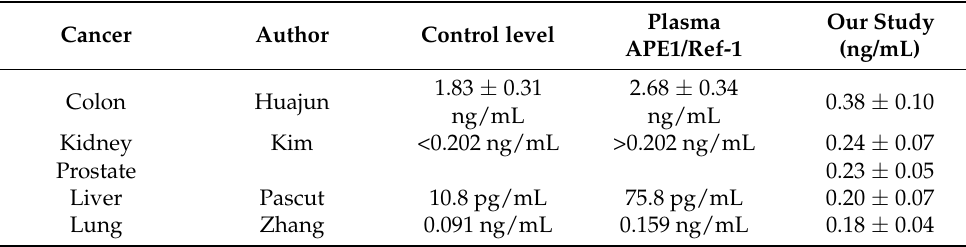
Table 5. Plasma APE1/Ref-1 levels in other